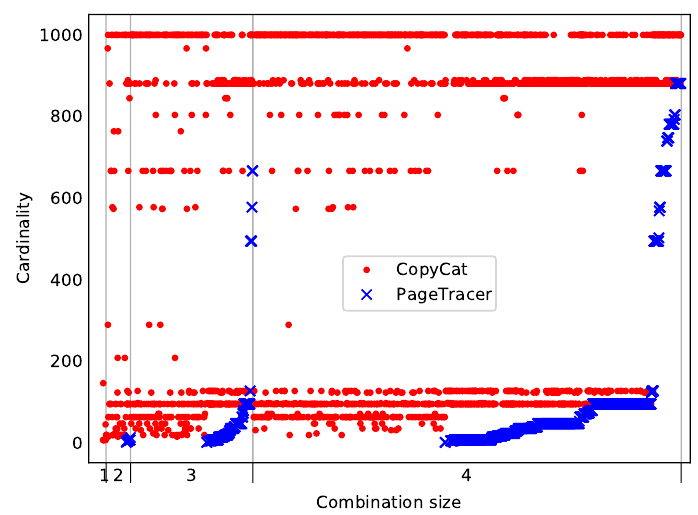
Figure 3: libgcrypt cardinality vs. combination size